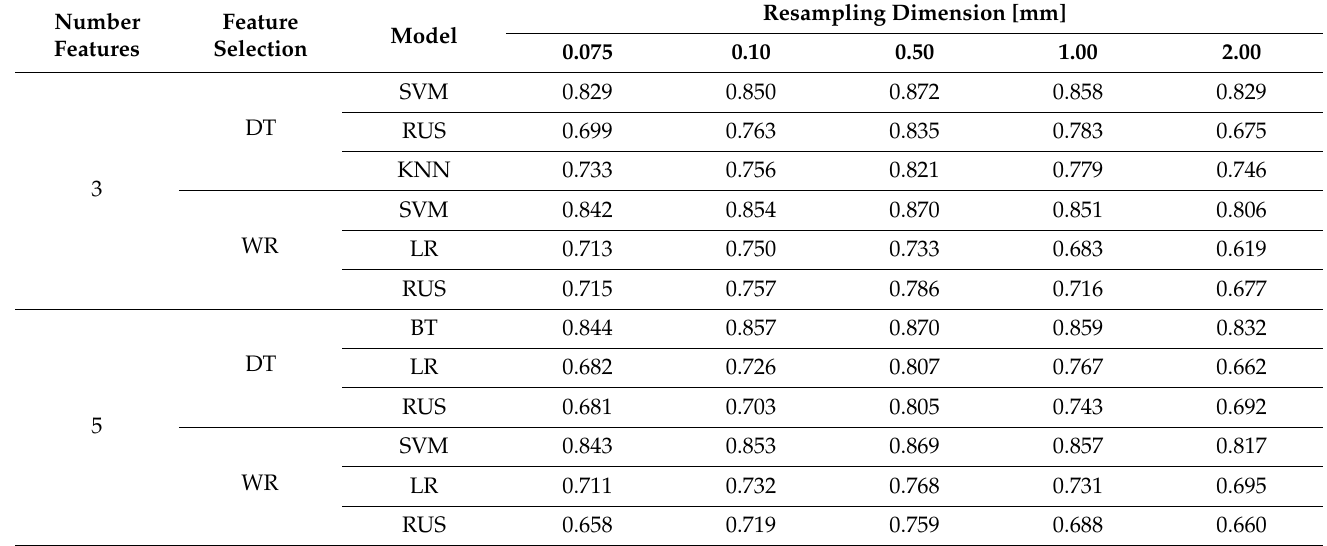
Table 5. Accuracies of top 3 models for 3, 5, 10, and 20 features from Tables 3 and 4 when subjected to different resampling dimensions of the µ CT